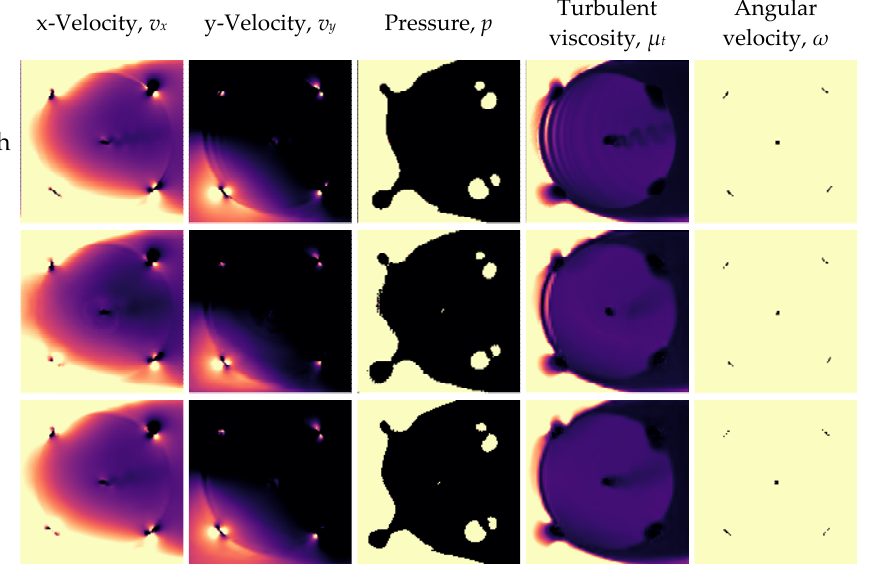
Figure 26. Ground truths and network predictions of Model 2 and Model 3, for the testing case of v ∞ = 2.0 m/s.